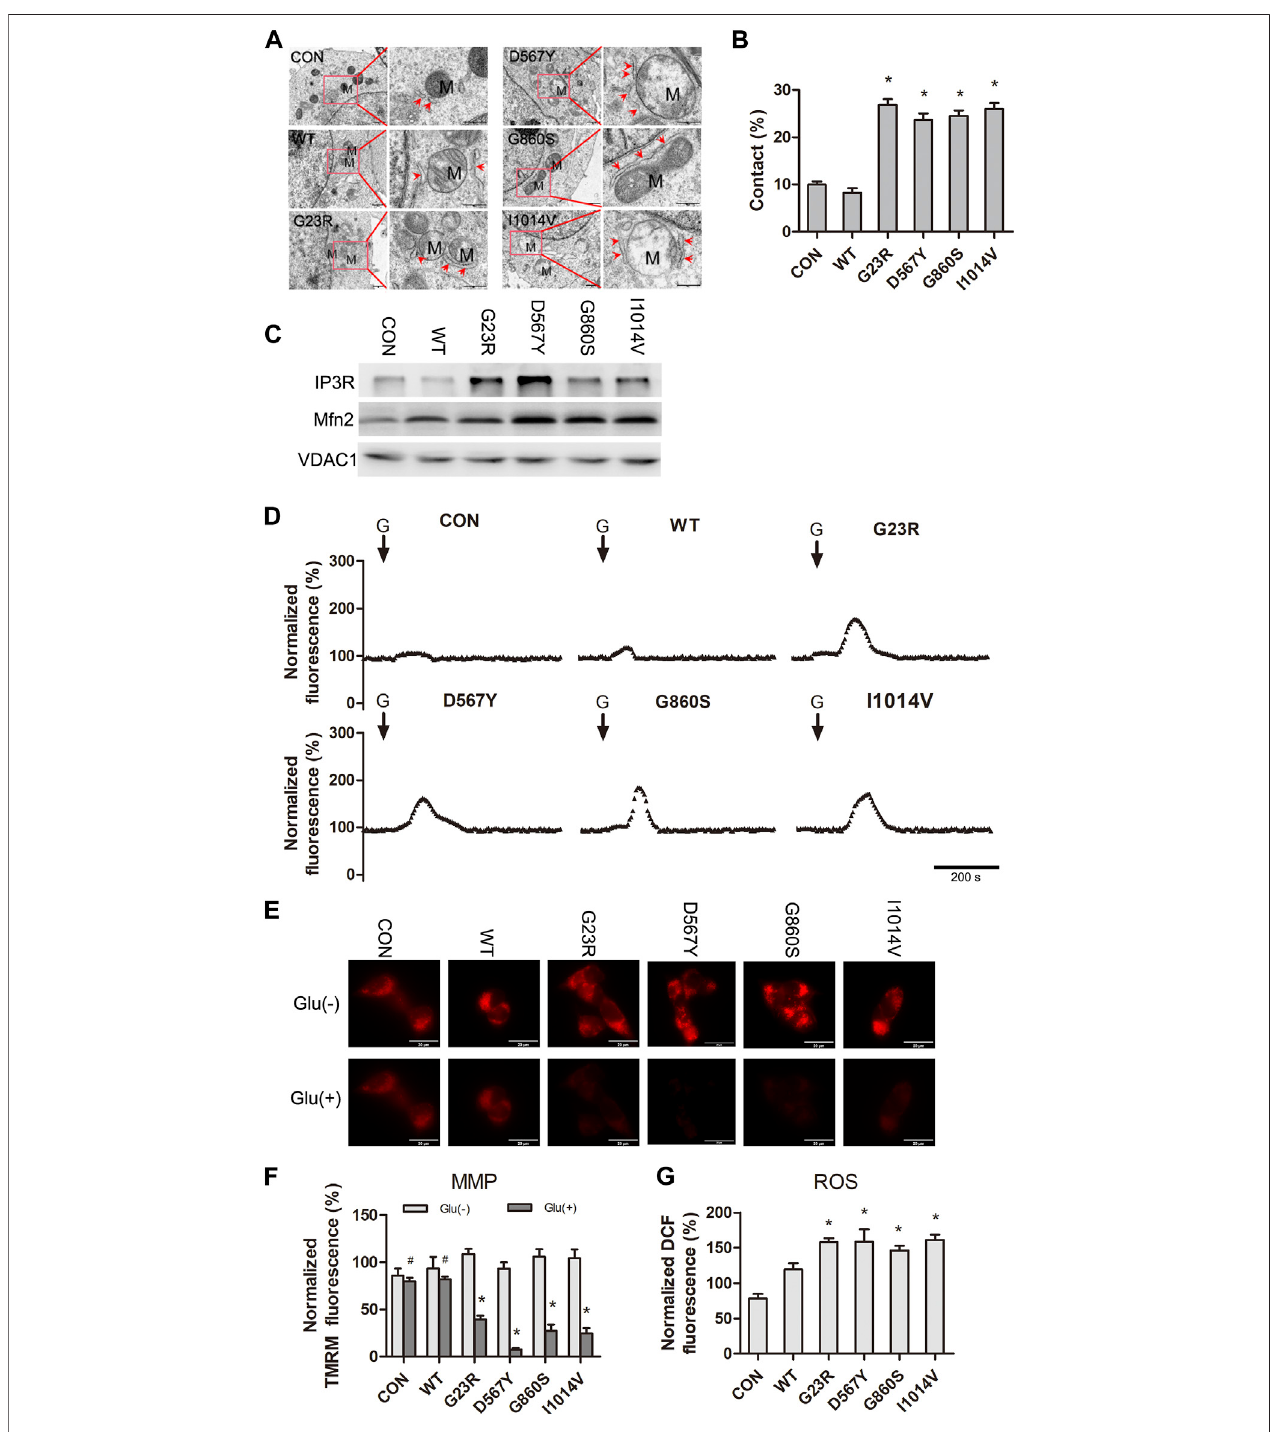
FIGURE4 | SERCA2 mutants increase mitochondrial-ER contacts leadingtomitochondrial Ca 2+ overload and dysfunction under hypo-glutamate stimulation. (A) : Representative electron micrographs of mitochondria-ER contact SERCA2 mutants. M: mitochondria; red arrows indicate ER. The scale bar is 1 µm (left line), 500 nm (right line). (B) Quanti fi cation of the mitochondrial surface percentage in close apposition to the ER. * p < 0.05 compared with WT group. (C) : Increasing of the calcium channel protein (IP3R and Mfn2) from speci fi cally isolated MAM fractions in SERCA2 mutants by Western Blotting. (D) : Representative normalized fl uorescence of mitochondria Ca 2+ by Rhod-2AM. Scale bar, 200 s. (G) : glutamate. (E,F) : Decreased mitochondrial membrane potential in SERCA2 mutants. Representative immunostaining (E) and quanti fi cation (F) of TMRM fl uorescence. * p < 0.05 compared with no-glutamate treatment. # p > 0.05 compared with no-glutamate treatment. (G) : Increased level of ROS in SRECA2 mutants by DCFH immunostaining. * p < 0.05 compared with WT group.